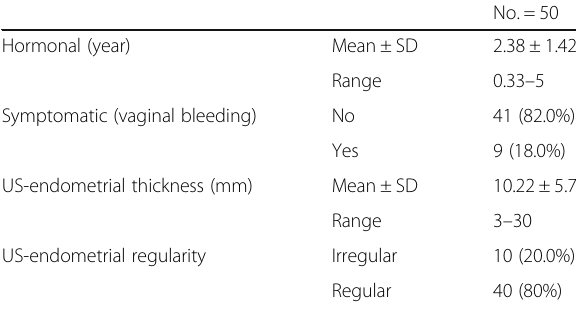
Table 2 Representing distribution of patients according to